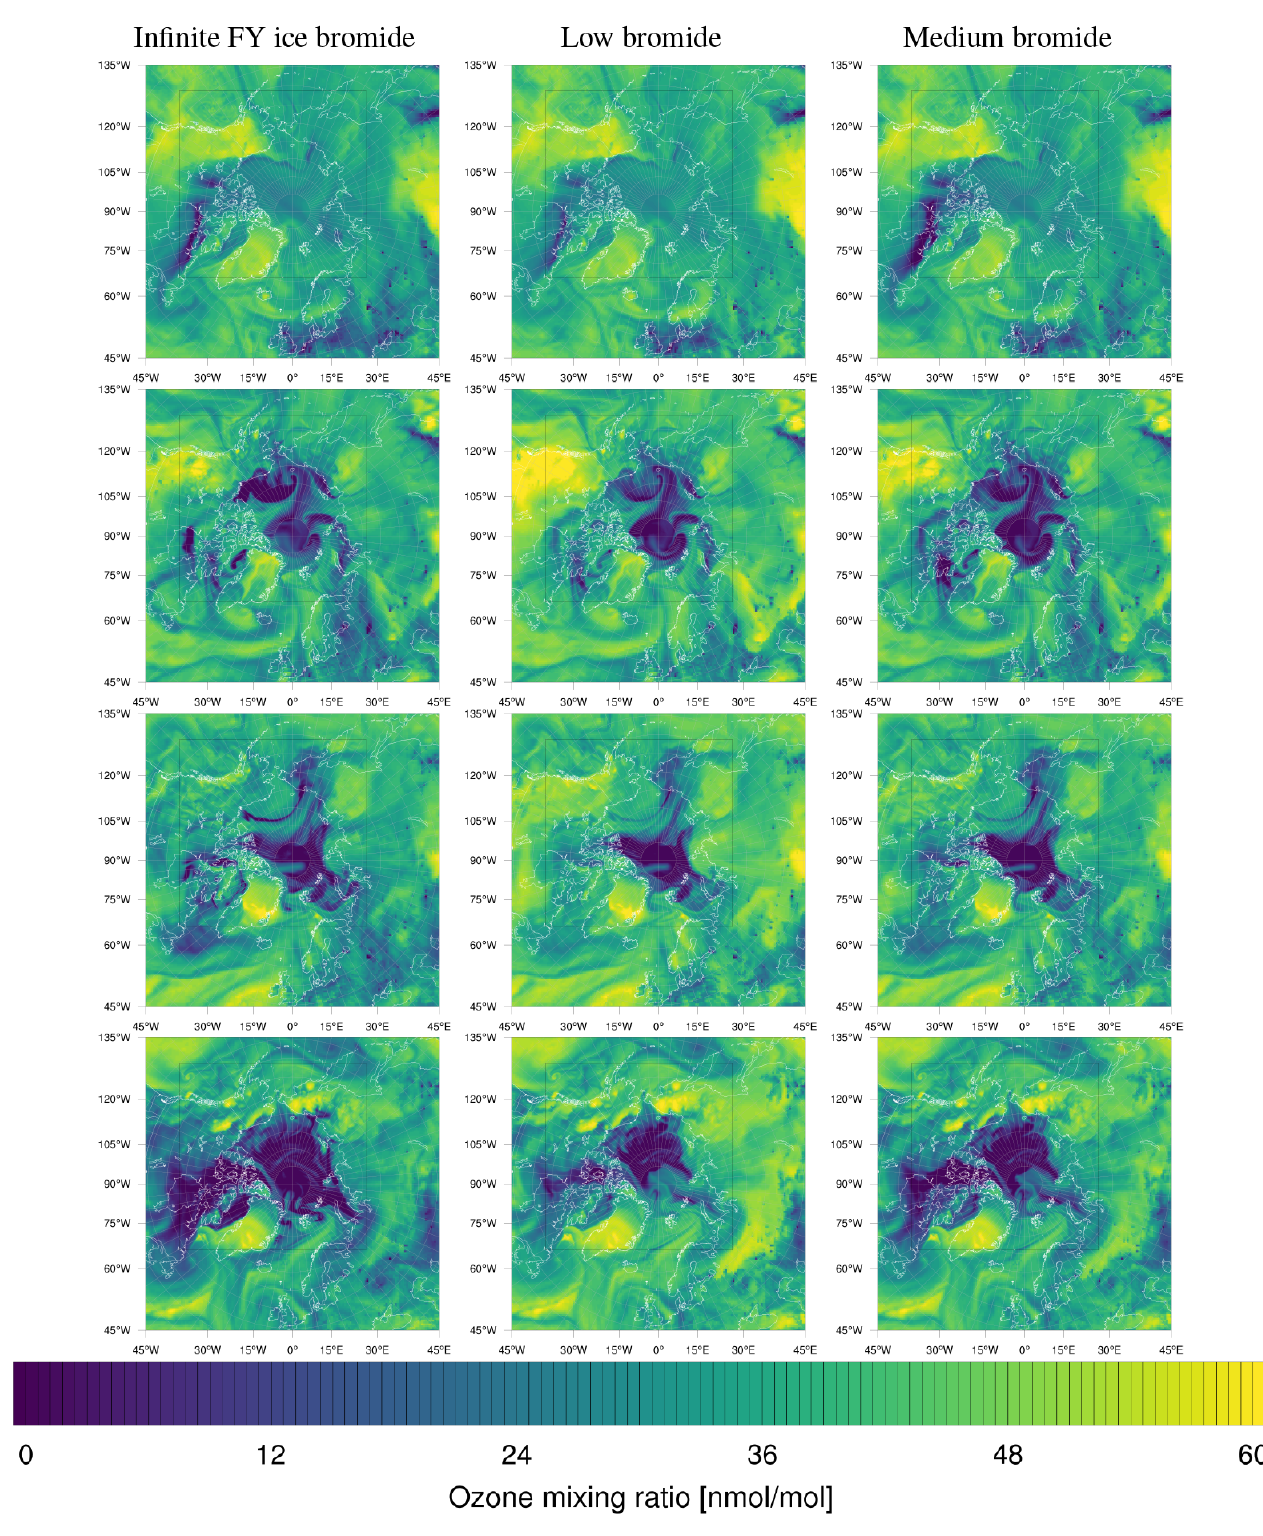
Figure 10. Simulated ozone mixing ratio at the ground level. From top to bottom: 27 February at 18:00GMT; 19 March at 20:00GMT; 27 March at 20:00GMT; 5 April at 16:00GMT.